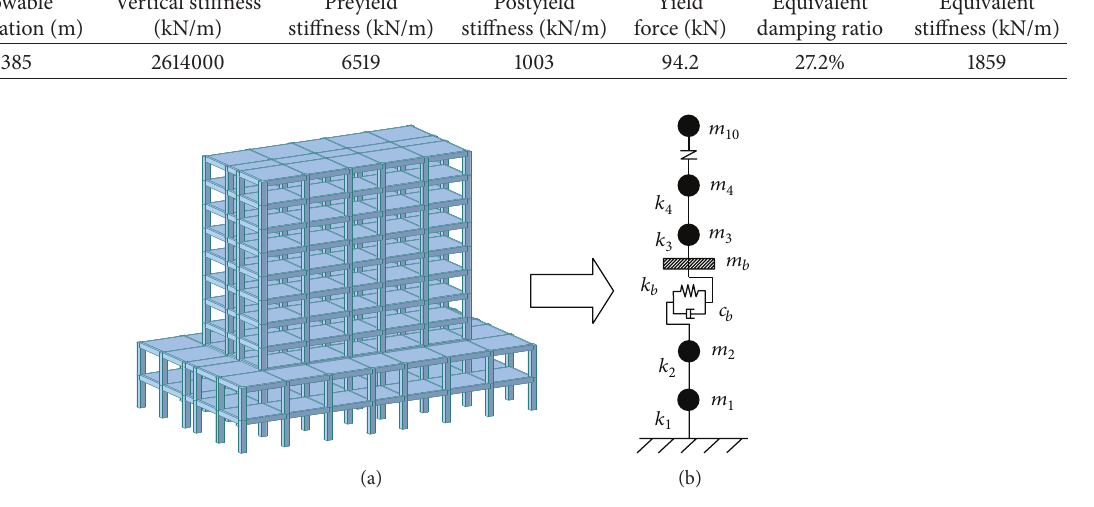
Figure 6: Midstory isolated test structure. (a) Structural model; (b) simplified mechanical